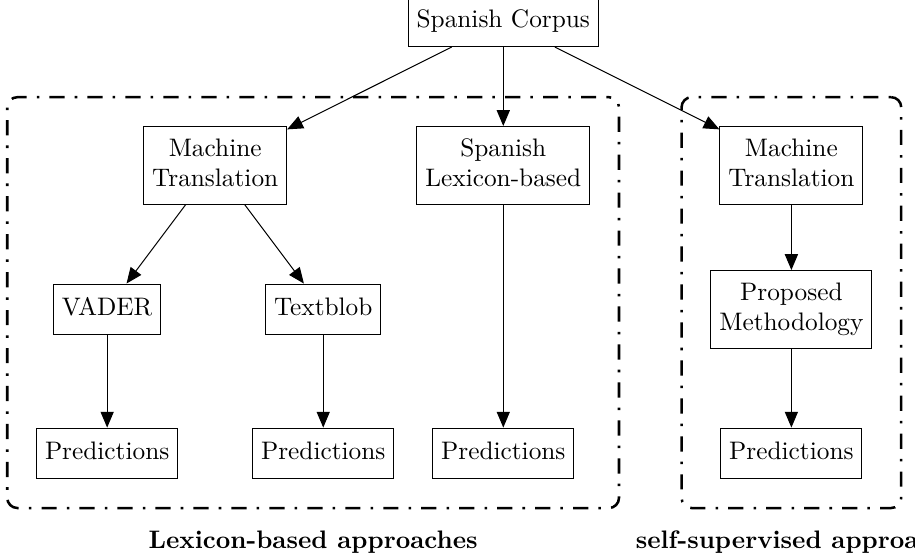
Figure 1. Validation procedure using some state-of-the-art lexicon-based